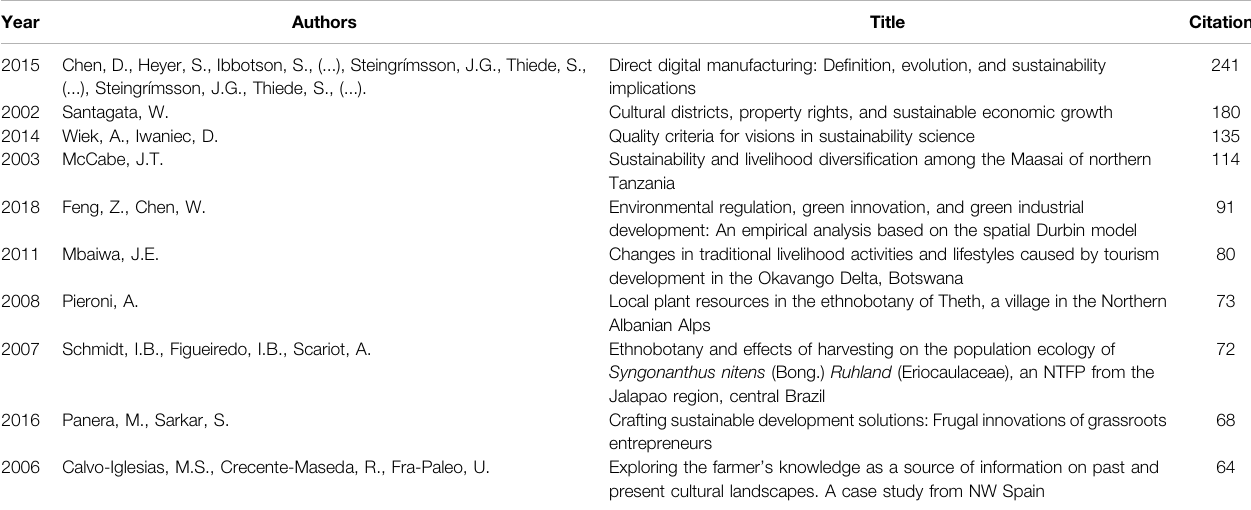
TABLE 2 | Most relevant publications on sustainable crafts. Source: Authors ’ own.